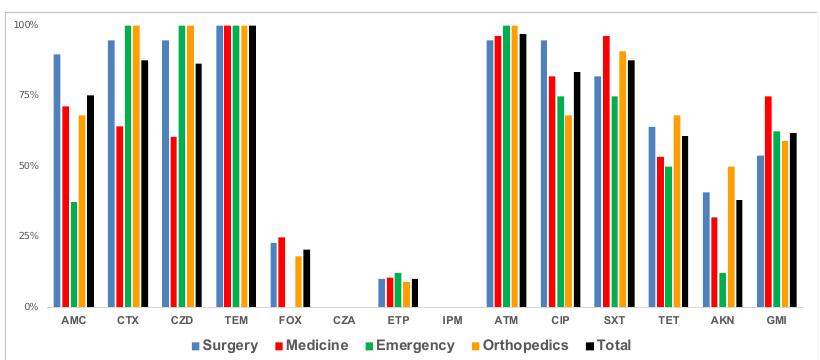
Figure 1. Antimicrobial resistance among the 97 ESBL- and carbapenemase-producing enterobacterial isolates, by ward. AMC—amoxicillin/clavulanic acid; CTX—cefotaxime; CZD— ceftazidime; TEM—temocillin; FOX—cefoxitin; CZA—ceftazidime/avibactam;